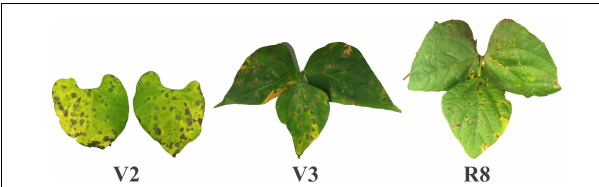
FIGURE 2 | Necrotic spots in angular shape and chlorosis, characteristic symptoms of angular leaf spot disease in the resistance evaluations for the V2, V3, and R8 plant growth